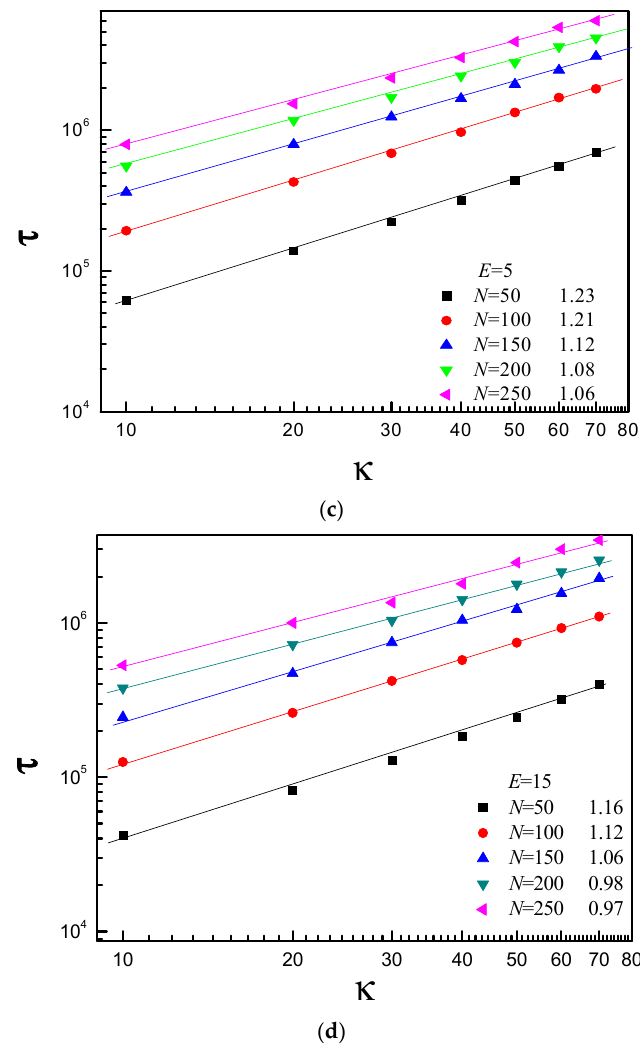
Figure 6. The average translocation time τ as a function of bending stiffness κ for the different chain length N at: ( a ) E = 1.5; ( b ) E = 3; ( c ) E = 5; and ( d ) E = 10. Here, R = 5.